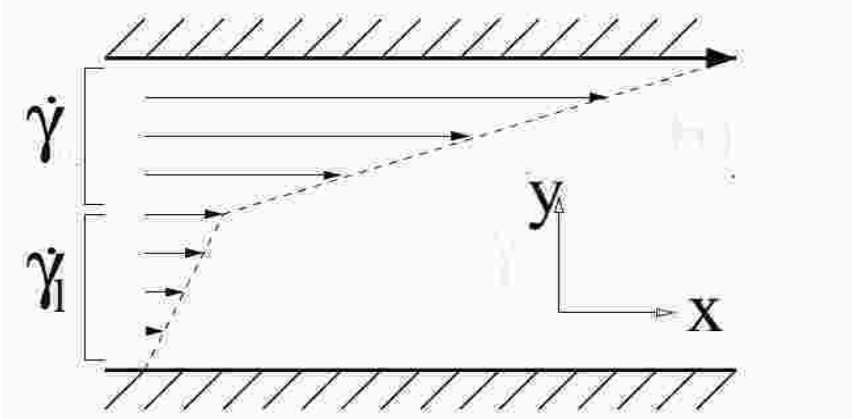
Figure 1. Shear banding profile showing two different shear rates (shear